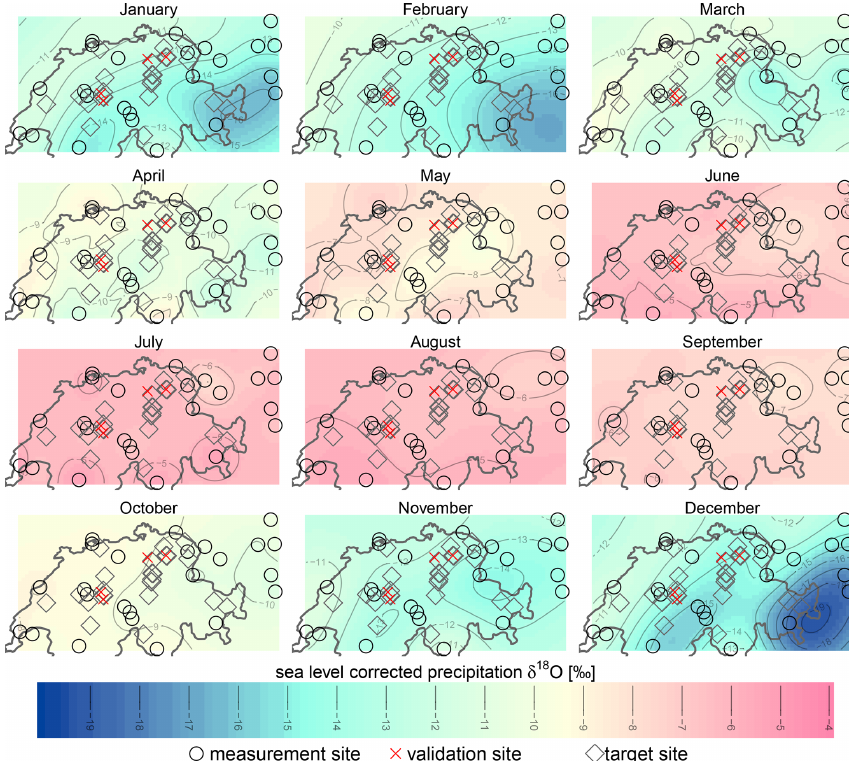
Figure 8. Monthly maps of sea-level-corrected δ 18 O in